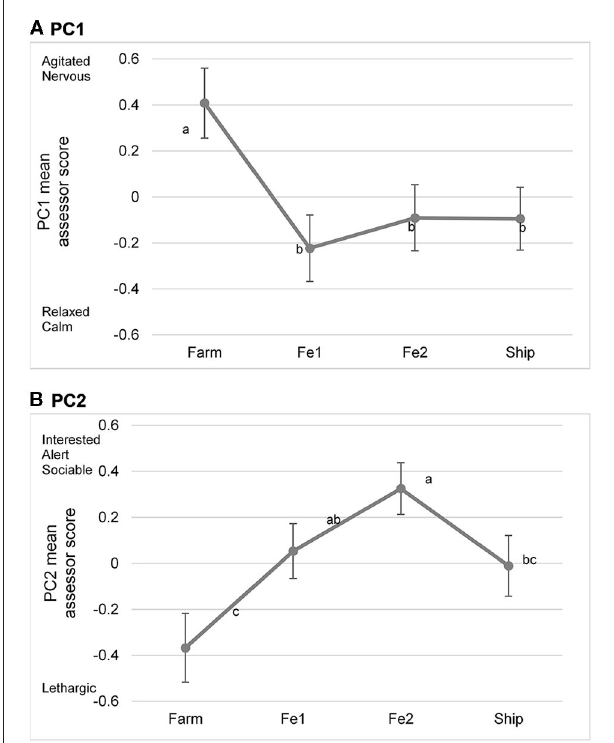
FIGURE 2 | Means ( ± std error) of assessor scores for (A) PC1 and (B) PC2 across the four locations ( n = 144 per location/timepoint). Note: letters link location that were not significantly different to each other ( p < 0.05).